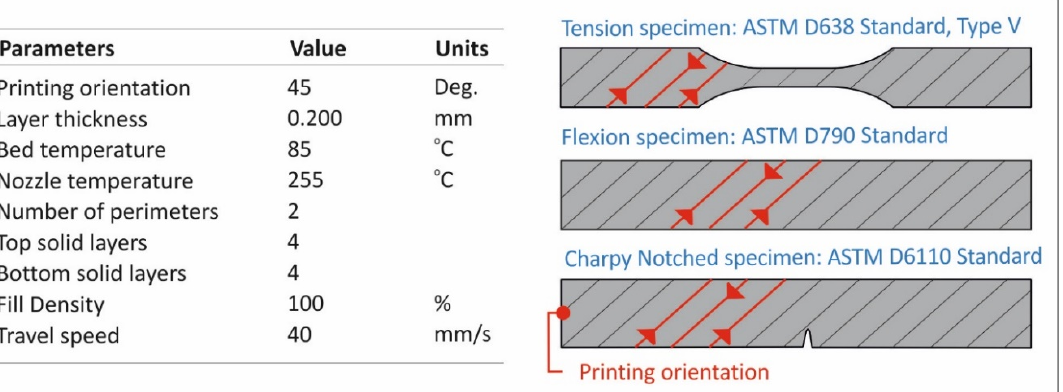
Figure 2. The optimum FFF 3D printing parameters followed in this study and set up to slicer software to manufacture the neat PLA, as well as the PLA/CB different nanocomposite specimens.